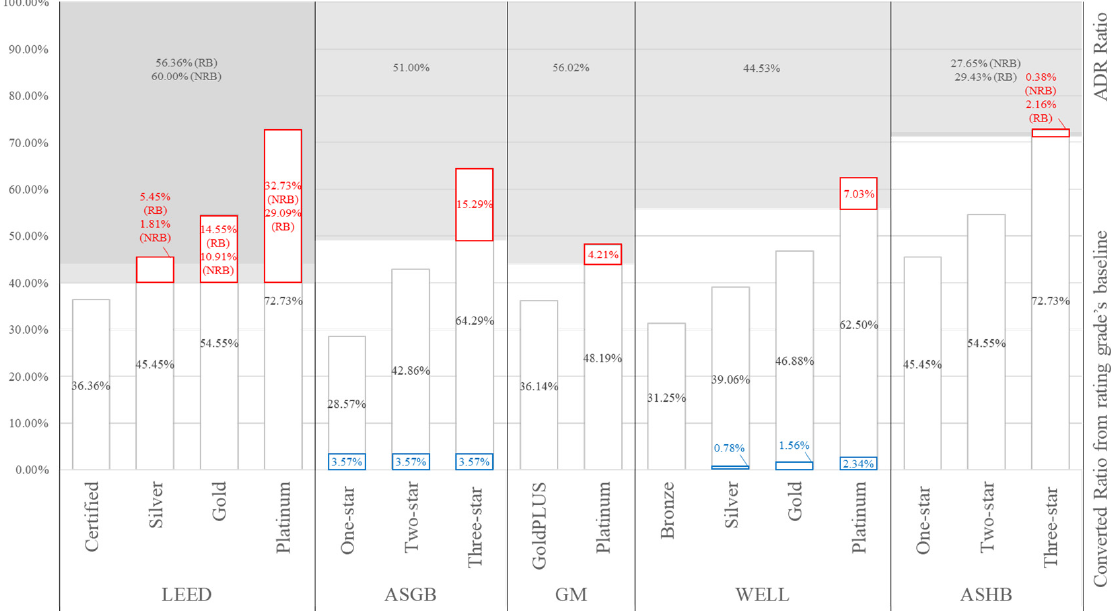
Figure 5. Calculation of minimum ADR ratios by ranking grade’s baselines and minimum point requirements for each category. (Source: by the author). Baseline column: the bottom-up white column that shows the ratio converted from a ranking grade’s baseline; ADR column: the top-down gray column that shows the ADR ratio of scoring items in Figure A7; Minimum ADR ratio: the red square where the baseline column and ADR column overlap, and the blue square which shows the ratio calculated from both the minimum point requirement for each category and ADR ratio of category. Table 3. ADR ratios and minimum ADR ratios in GBRSs. (Source: by the author).